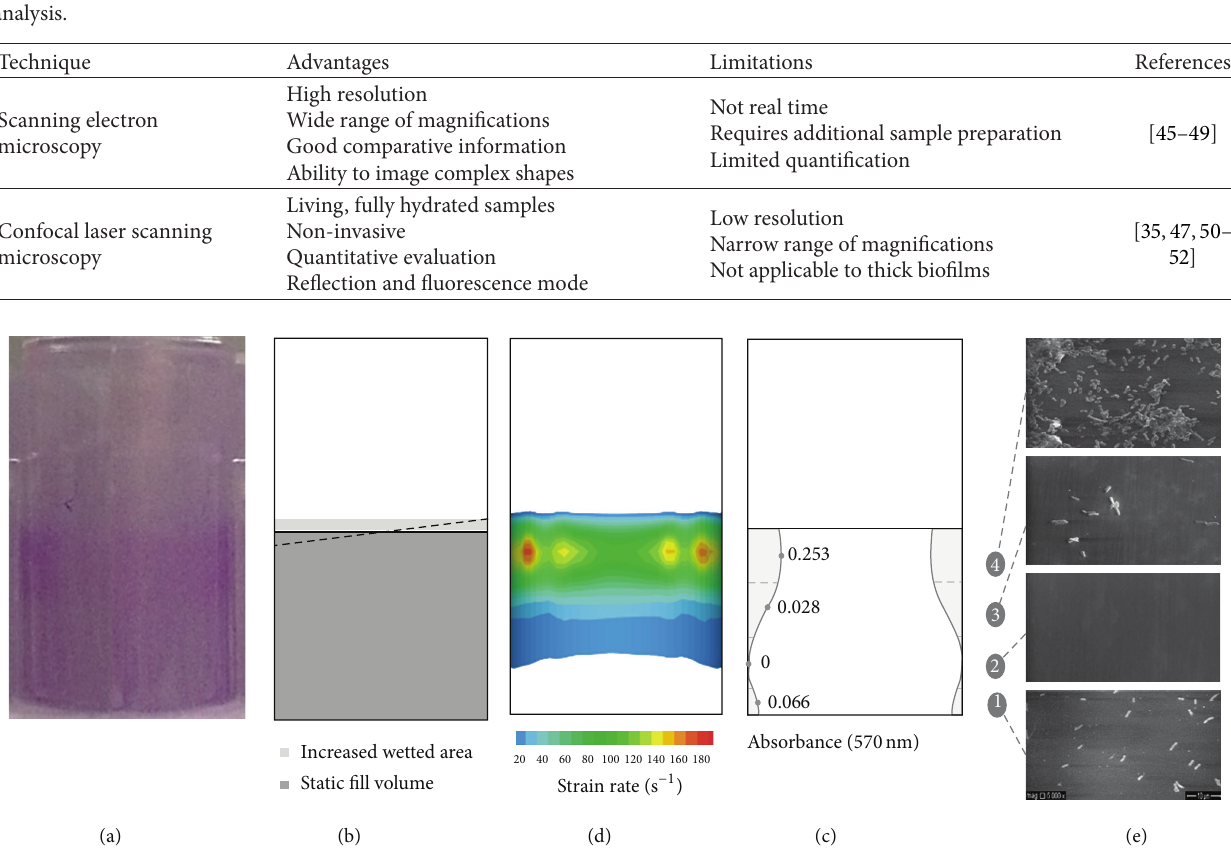
Figure 1: Biofilm localization in shaking 96-well microtiter plates placed in a 50 mm incubator at 150rpm. (a) Photograph of a well stained with crystal violet; (b) schematic representation of a well where the dark grey area corresponds to the wetted area without shaking, the light grey area represents the area increase upon shaking, and the dotted line depicts the inclination of the air-liquid interface; (c) time averaged shear strain rates (values below 20 s −1 are not represented); (d) illustration of the biofilm distribution on the vertical wall assayed by the differential CV staining; (e) representative scanning electron micrographs of the wall sections defined in image (d); (5000x magnification bar = 10 𝜇